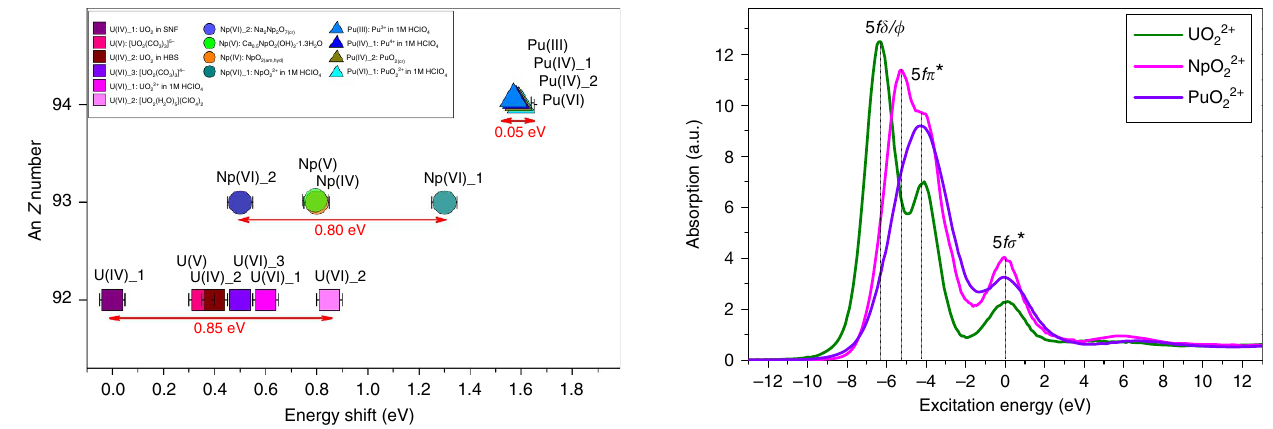
Figure 4 | Energy shifts obtained from RIXS maps. Energy shift of the main resonance peak (line A in Figs 2 and 3) compared to the energy position of the normal emission line (line B in Figs 2 and 3) for different U, Np and Pu materials measured at the U M 4 (filled squares) and Np/Pu M 5 absorption edge (Np: filled circles and Pu: triangle). Spent nuclear fuel and high-burn up structure are abbreviated with SNF and HBS, respectively. Information about the samples in given in SI (cf. Supplementary Table 1; Supplementary Note 1).